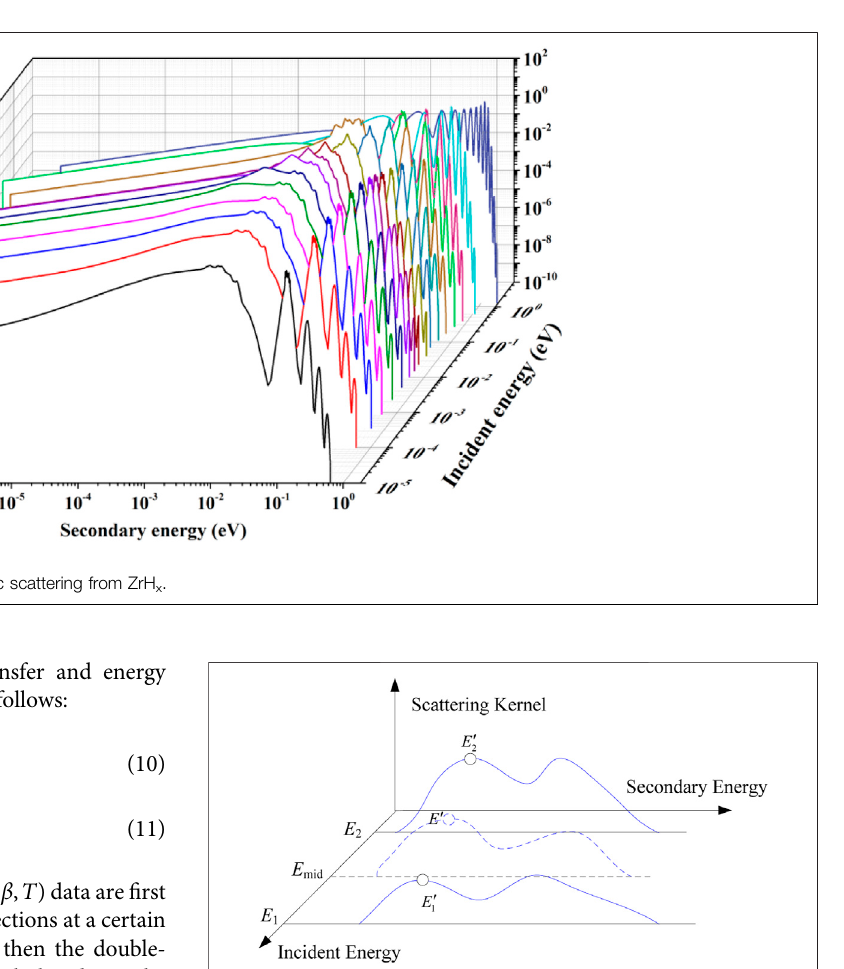
FIGURE 2 | De fi nition of the secondary energies for multipoint